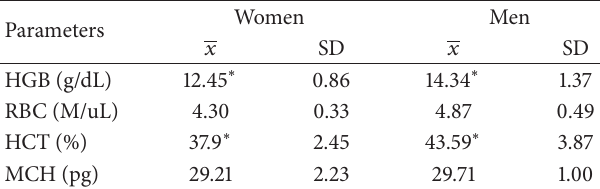
Table 1: Average values of selected blood morphology parameters. Parameters